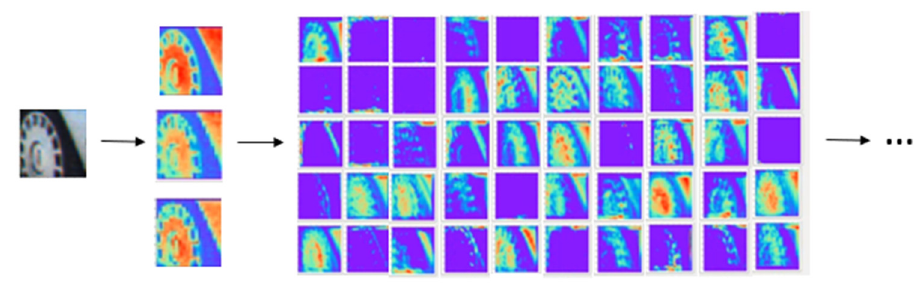
Figure 2. Visualization of the feature map extracted by the proposed method.